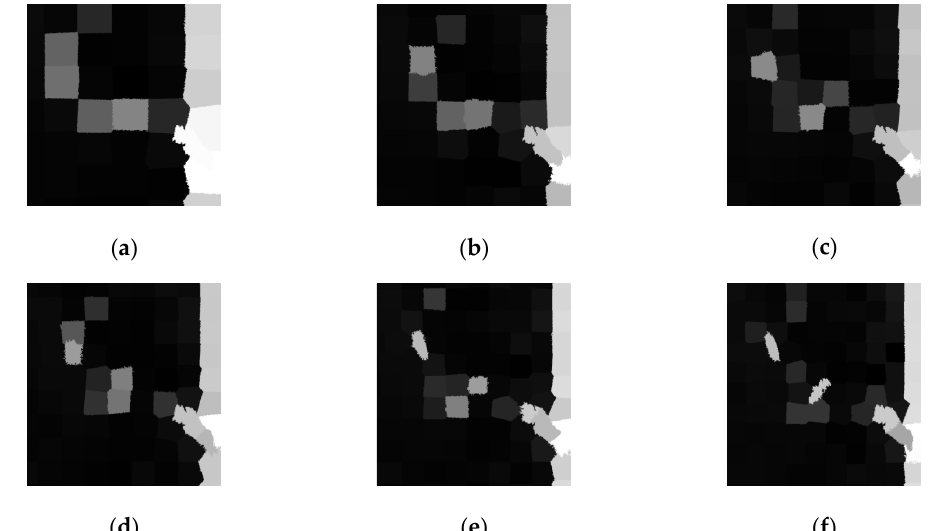
Figure 11. SLIC superpixel segmentation results with different superpixel numbers. ( a ) 150, ( b ) 200, ( c ) 250, ( d ) 300, ( e ) 350, ( f ) 400. Table 8. Total MIoU results of Yamaguchi parameters combined with different SLIC parameters.